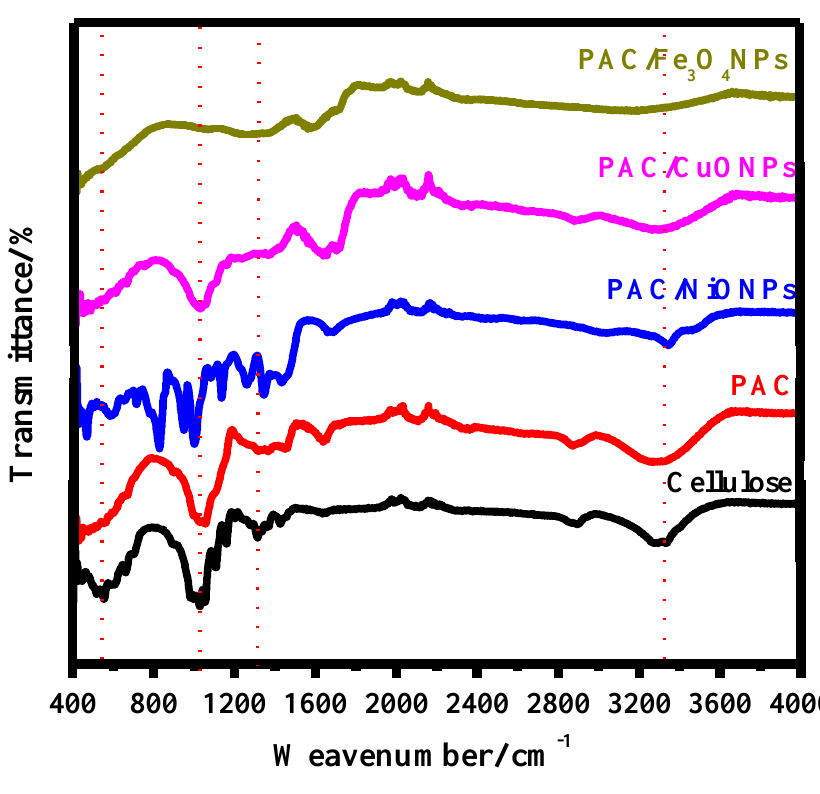
Figure 1. FTIR spectral analysis of cellulose, primary aminated modified cellulose (PAC), PAC/NiONPs, PAC/CuONPs and PAC/Fe 3 O 4 NPs nanocomposites.